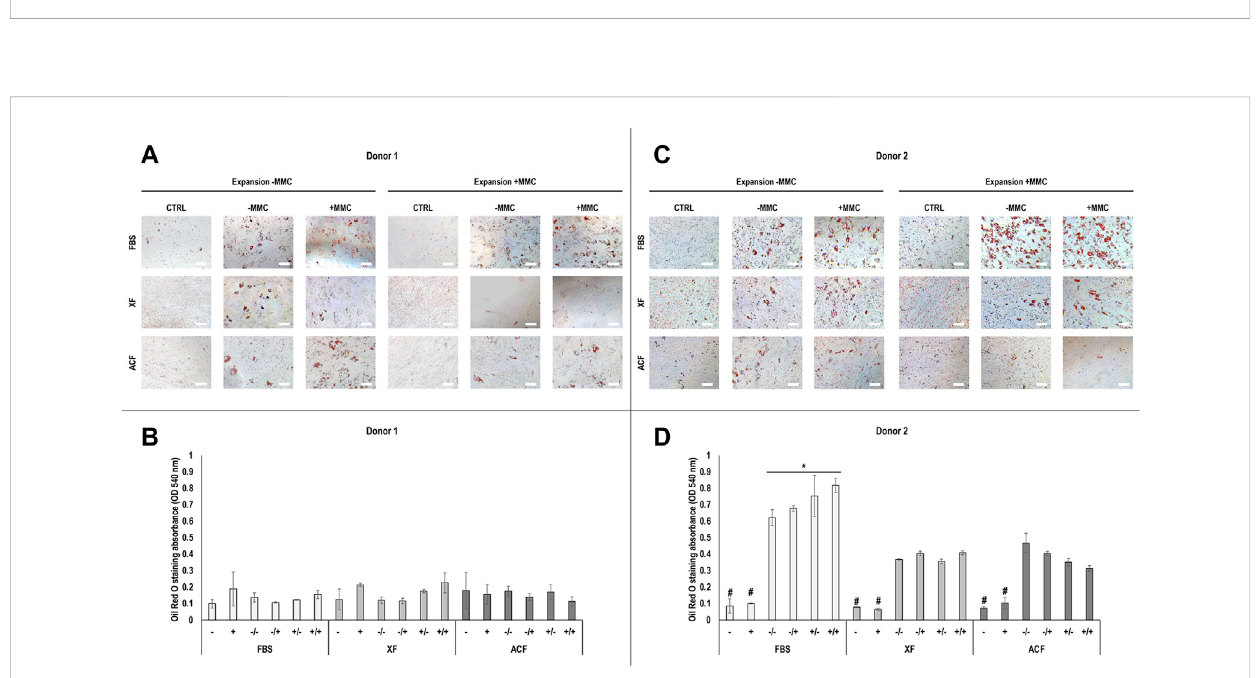
FIGURE 3 Oil Red O staining and corresponding semi-quantitative absorbance analysis of hBMSCs of donor 1 (A, B) and 2 (C, D) , expanded with or without MMCinACF,XFandFBScontainingmedia,anddifferentiatedwithadipogenicinductionmediawithorwithoutMMCsupplementationatp4.Experiments were performed in three technical replicates. # indicates the lowest statistically signi fi cant value ( p < 0.05) at a given time point. * indicates the highest statistically signi fi cant value ( p < 0.05) at a given time point. Scale bars: 100 μ